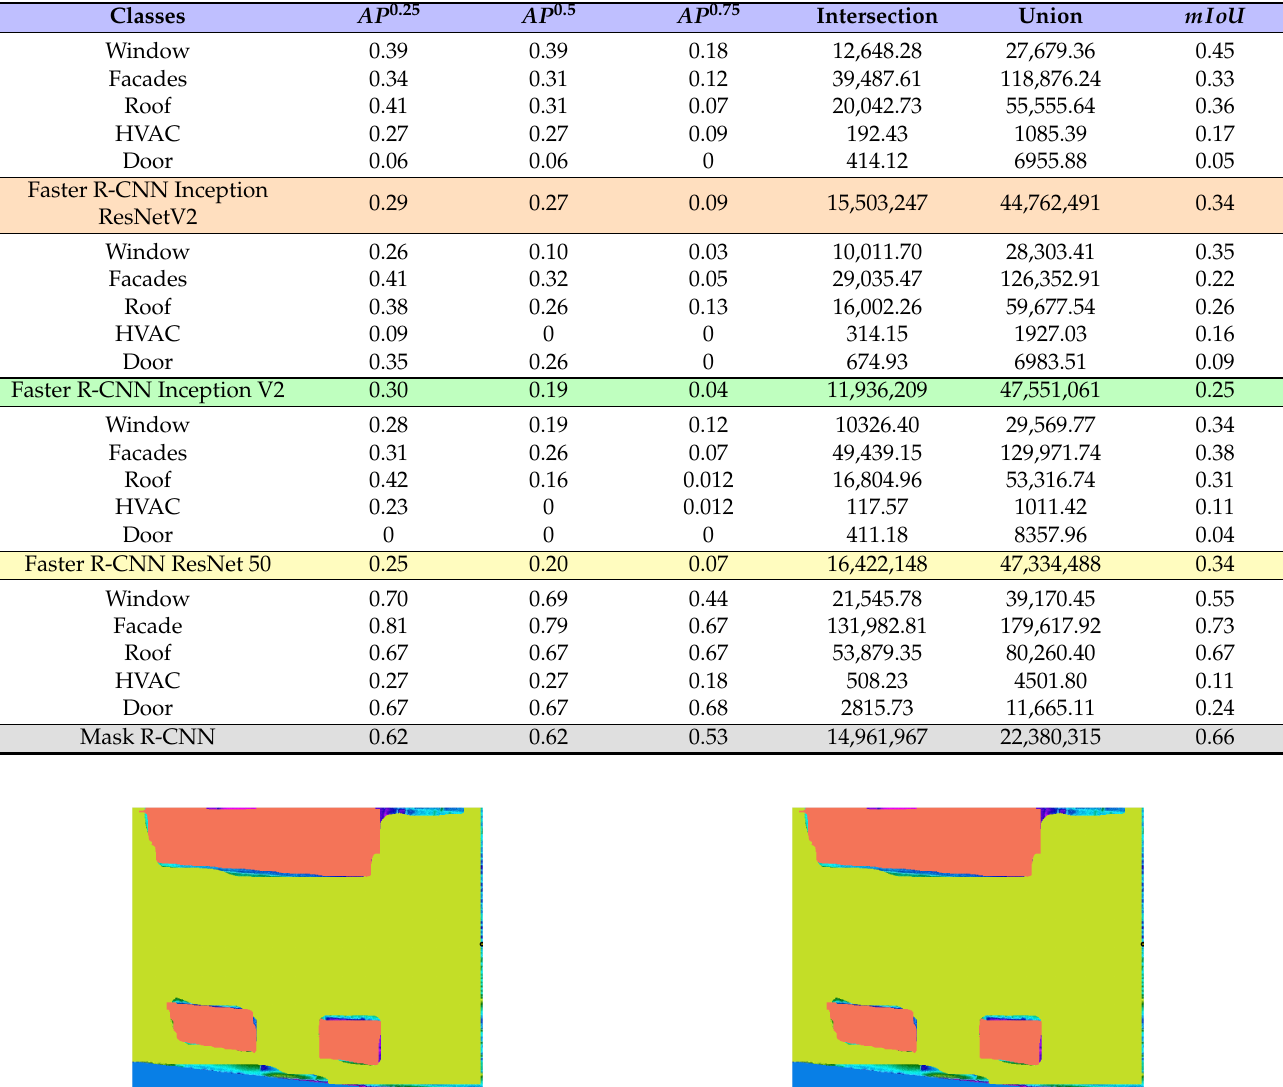
Table 6. The average precision of computer vision algorithms trained and tested on OGI thermal images with three different threshold values for five classes: windows, facades, roofs, HVACs, and doors.